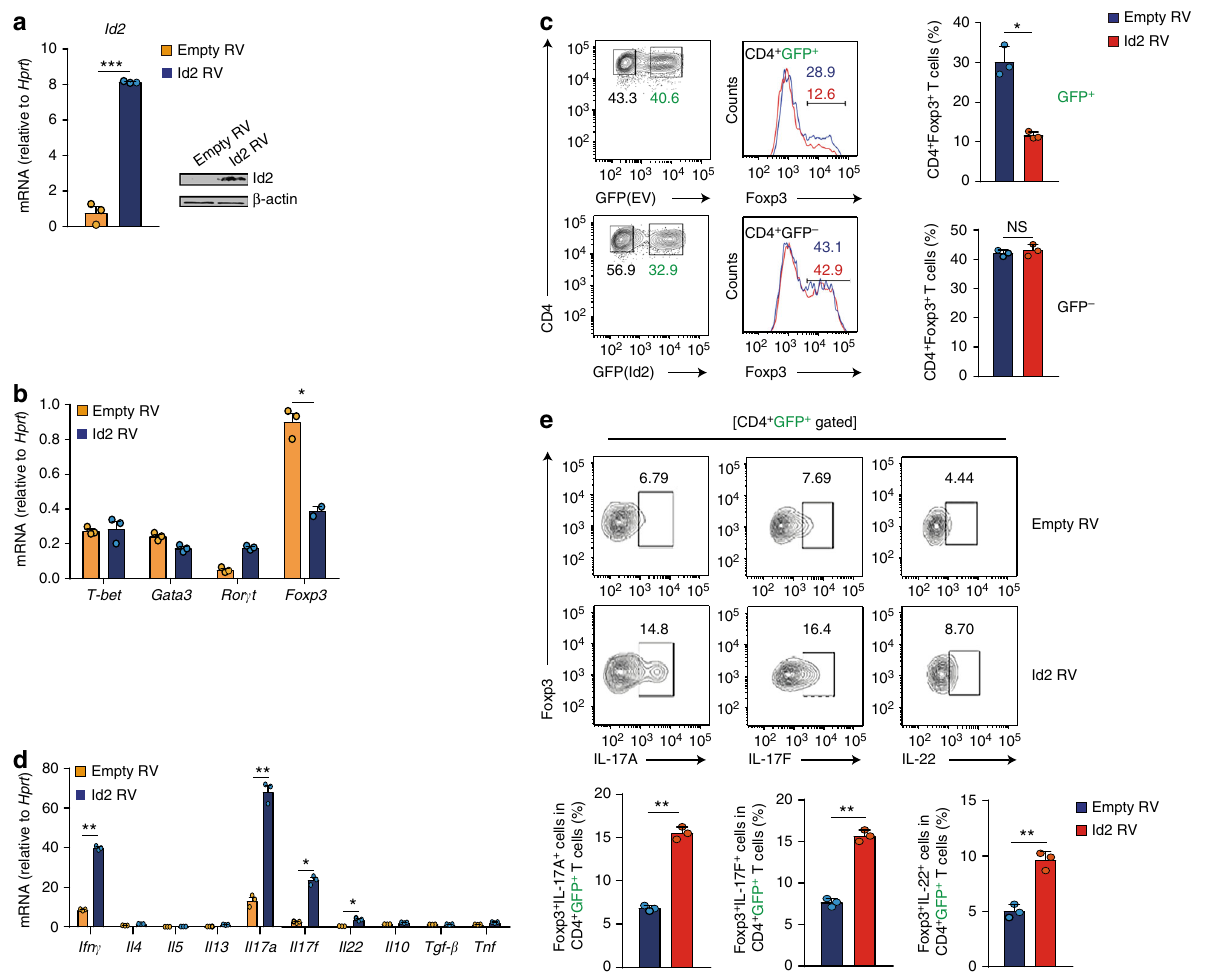
Fig. 2 Overexpression of Id2 in vitro fails to stabilize iT reg lineage commitment, and convert them into T H 17-like cells. a Naive CD4 + T cells were sorted from wild-type C57BL/6 (B6) mice, and transduced with control vector (Empty RV) or vector encoding Id2 cDNA (Id2 RV) under iT reg differentiation condition. After 3 days cells were harvested and Id2 expression was measured by RT-qPCR ( n = 3, per group) and Western blot analysis. b Comparison of mRNA expression for T-bet , Gata3 , Ror γ t and Foxp3 between Empty RV and Id2 RV transduced T cells after 3 days post spinfection under iT reg differentiation condition ( n = 3, per group). c Flow cytometry analysis of Foxp3 expression between Empty RV or Id2 RV transduced (GFP + ) and non- transduced (GFP − ) iT reg cells ( n = 3, per group). d Comparison of mRNA expression for genes encoding the indicated cytokines between Empty RV and Id2 RV transduced T cells after 3 days post spinfection under iT reg differentiation condition ( n = 3, per group). e Flow cytometry analysis of IL-17A, IL-17F and IL-22 from Empty RV or Id2 RV transduced CD4 + GFP + iT reg cells ( n = 3, per group). NS, not signi fi cant, * P < 0.05, ** P < 0.005 (Student ’ s t -test). All data are representative two or three independent experiments (error bars, which the cDNA encoding tdTomato is preceded by stop codon fl anked by loxP sites, and is expressed upon Cre-mediated recombination. The fate of Foxp3 expression in tdTomato + cells in these mice could be determined by monitoring YFP-Cre expression. Under this experimental condition upon induction of EAE, as expected even in control R26T Foxp3 YFP − Cre mice, increased Id2 expression was observed in the tdTomato + YFP − (ex-T reg ) cells, compared to tdTomato + YFP + (T reg ) cells, con fi rming a correlation between increased Id2 expression and